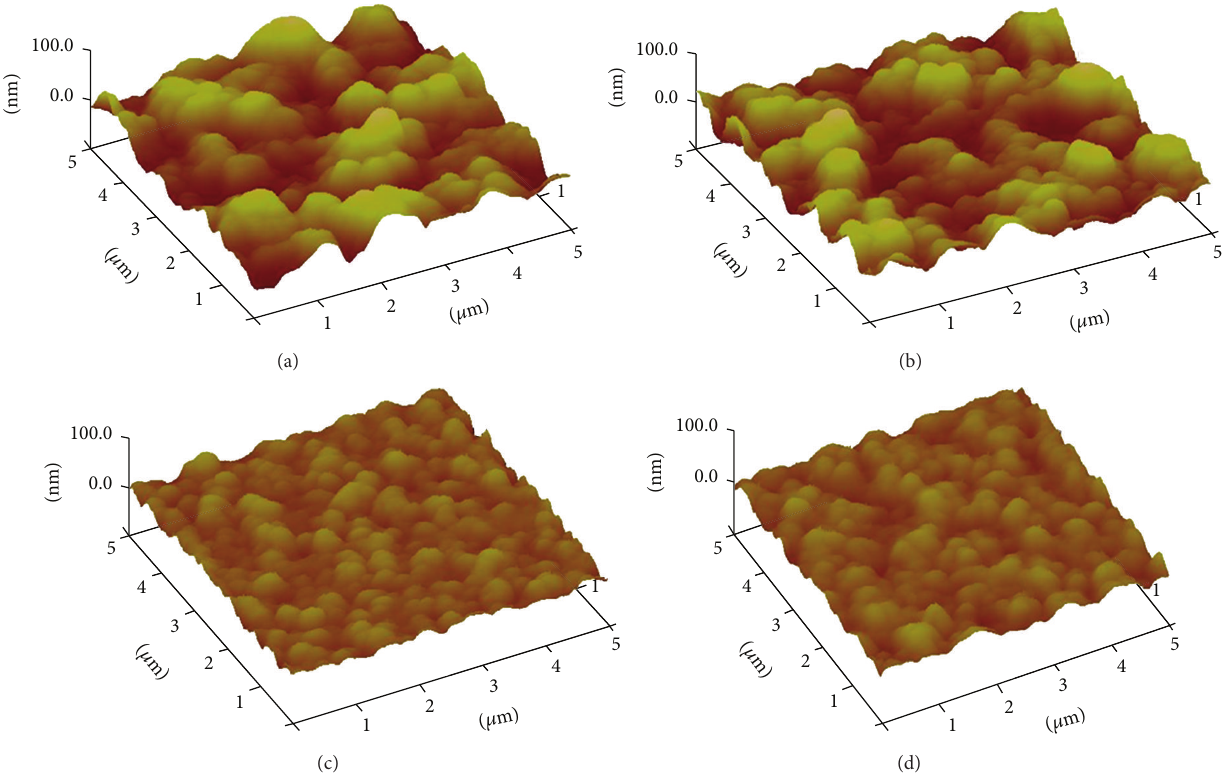
Figure 7: AFM height images (a) ITO \ PH500 \ P3HT:PC 60 BM (pristine) unannealed, RMS roughness 15nm, (b) ITO \ PH500 \ P3HT:PC 60 BM (pristine) annealed, RMS roughness 16.5 nm, (c) ITO \ PH500 \ P3HT:PC 60 BM layer (with 30 vol% glycerol additive) unannealed, RMS roughness 7.18nm, and (d) ITO \ PH500 \ P3HT:PC 60 BM (with glycerol 30 vol% additive) annealed, RMS roughness 7.37